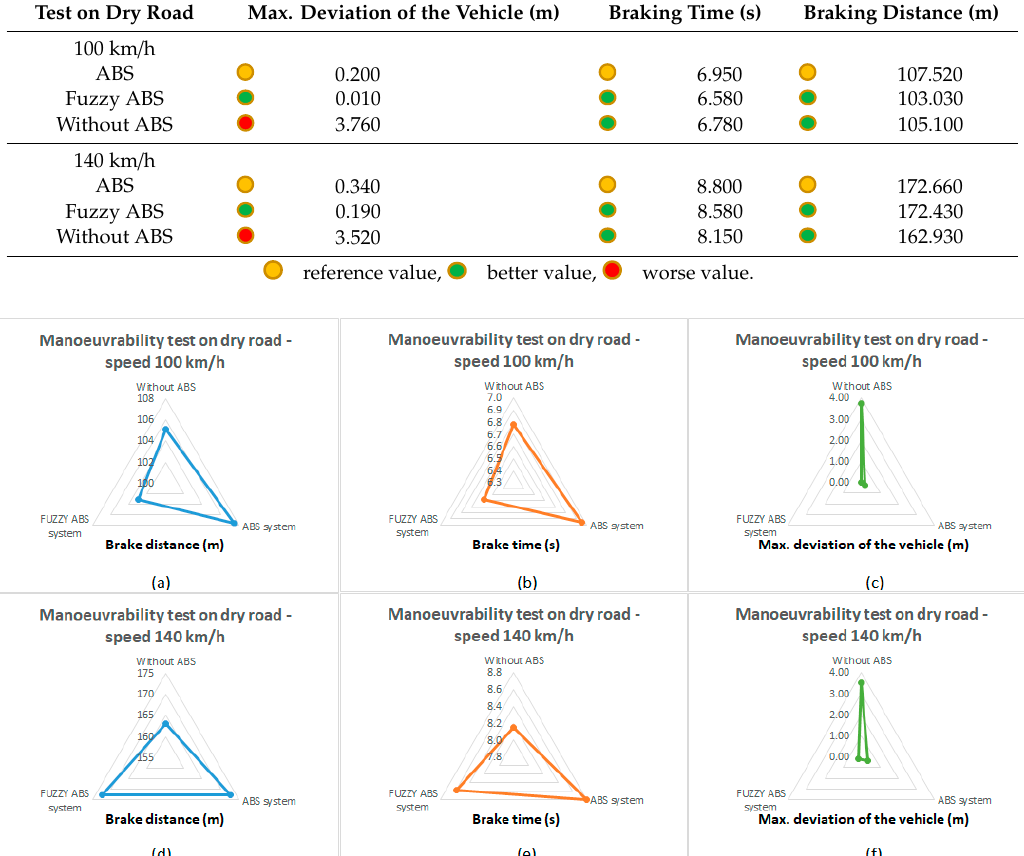
Table 11. Comparison of parameters during avoiding an obstacle on the road. Test on Dry Road